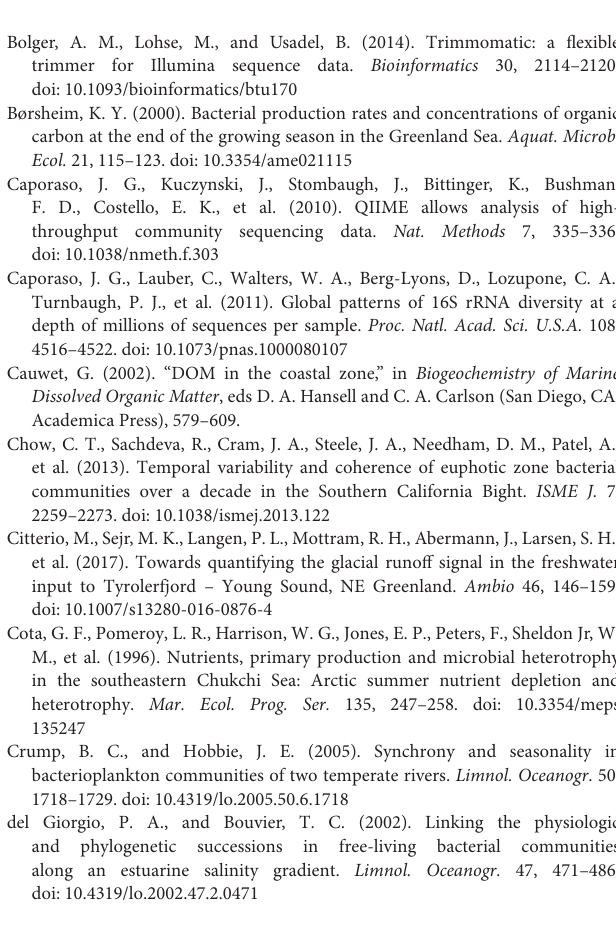
Figure S1 | Profiles of salinity, temperature ( ◦ C), DOC ( µ M), DOC:DON and the concentration of nutrients NO − 2 + NO − 3 and Si ( µ M) at the 4 stations in the periods from July-August (red colors) and September-October (blue colors). Figure S2 | Canonical correspondence analysis (CCA) for sequencing data of 16S rRNA gene fragments at RNA level (most abundant OTUs > 1%). Arrows indicate selected environmental variables: bacterial production, dissolved organic carbon (DOC), percent bioavailable dissolved organic carbon (%BDOC), fluorescence, temperature and salinity. The OTUs selected for further analysis are labeled with their genus classification. Figure S3 | Time-series measurements from Zackenberg River of temperature ( ◦ C), Sediment (mg L − 1 ), LOI (mg L − 1 ) (LOI is organic matter determined by Loss On Ignition when heated at 105 ◦ C ≈ particulate organic matter), DOC ( µ M). Data is collected by Greenland Ecosystem Monitoring, the GEOBASIS